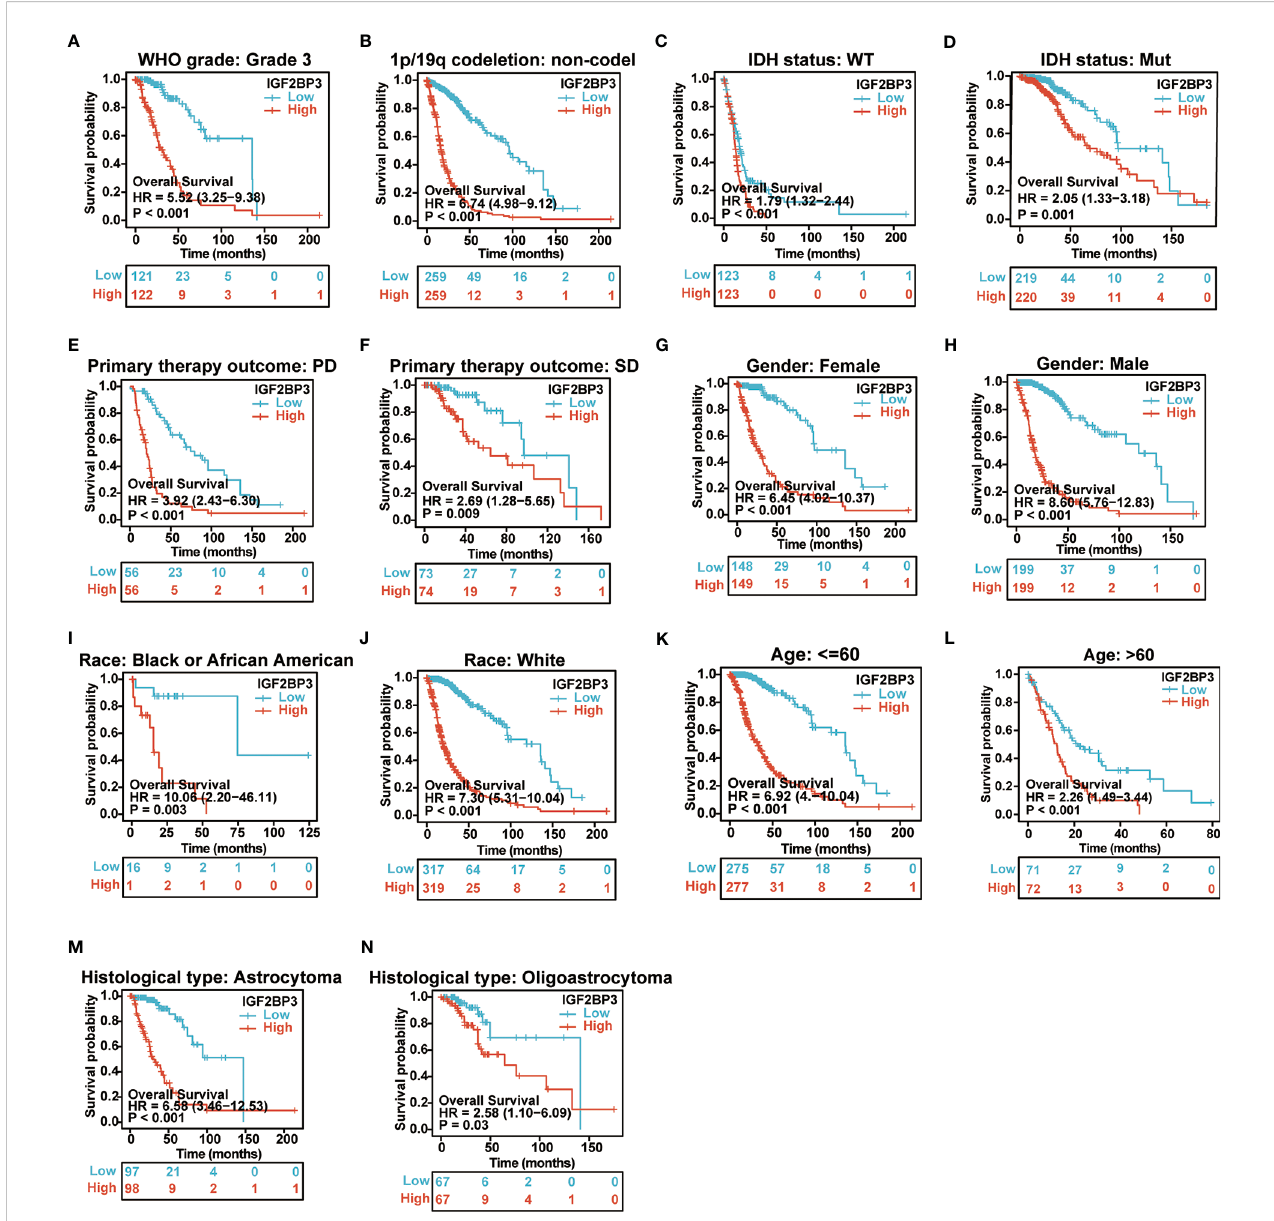
FIGURE 6 Associations between IGF2BP3 expression and the OS in different clinical subgroups of GBMLGG. (A) WHO grade (G3); (B) 1p/19q codeletion (non − codel); (C) IDH status (WT); (D) IDH status (Mut); (E) Primary therapy outcome (PD); (F) Primary therapy outcome (SD); (G) Gender (Female); (H) Gender (Male); (I) Race (Black or African American) (J) Race (White); (K) Age ≤ 60; (L) Age>60; (M) Histological type (Astrocytoma); (N) Histological type